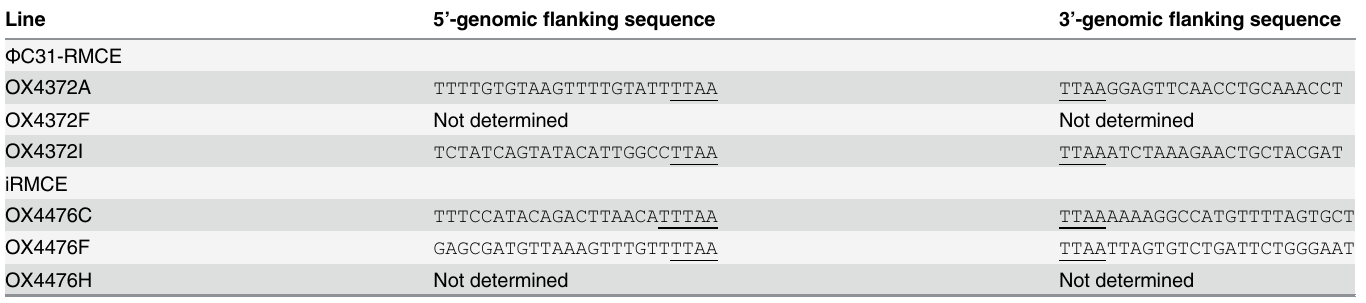
Table 1. Genomic flanking sequences of OX4372 and OX4476 in Ae . aegypti .